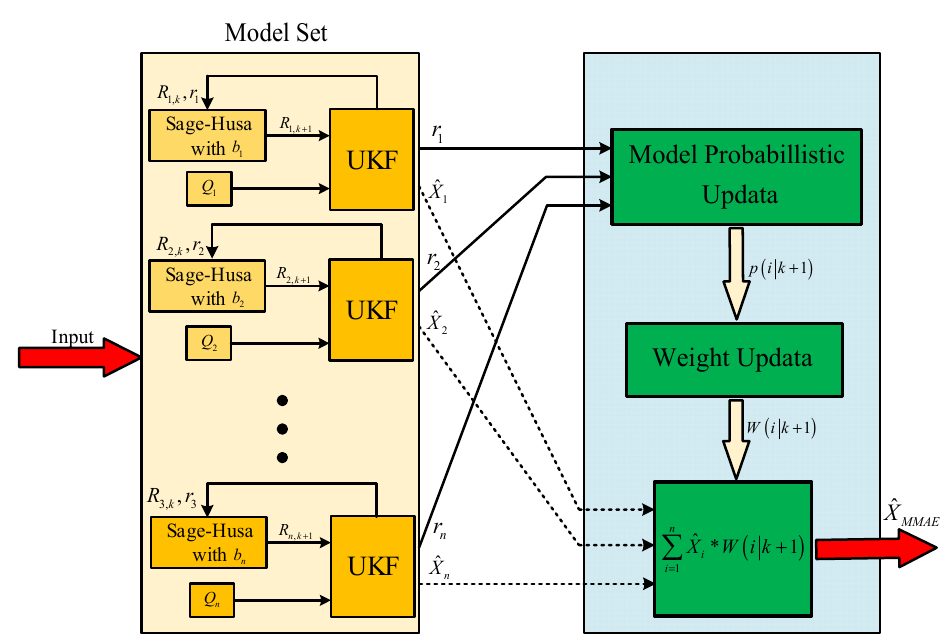
Figure 1. The structure diagram of improved MMAE.